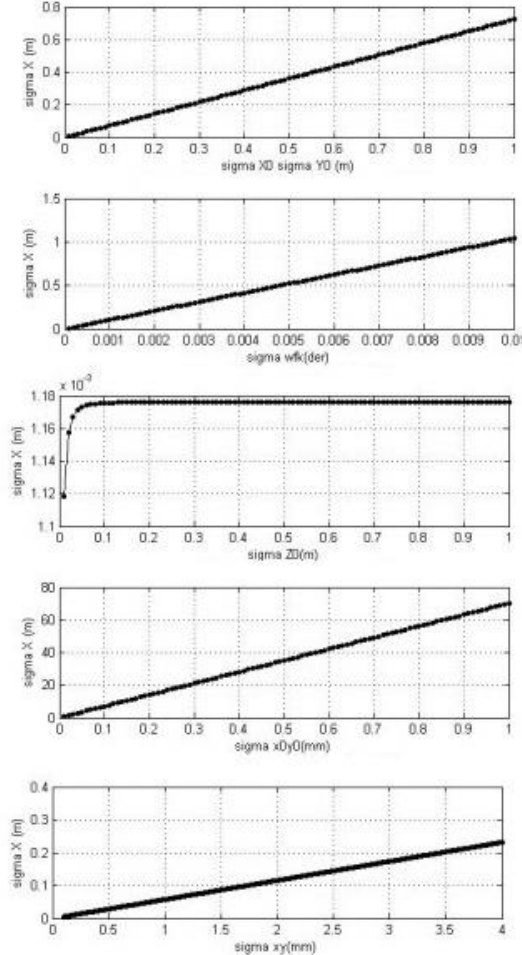
Figure 4.a Position uncertainty of Z component of each point